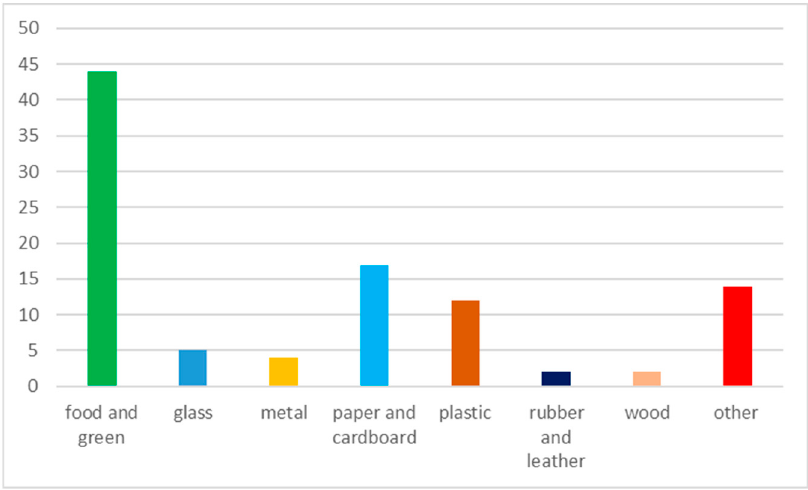
Figure 7. Global waste composition (%) [1].